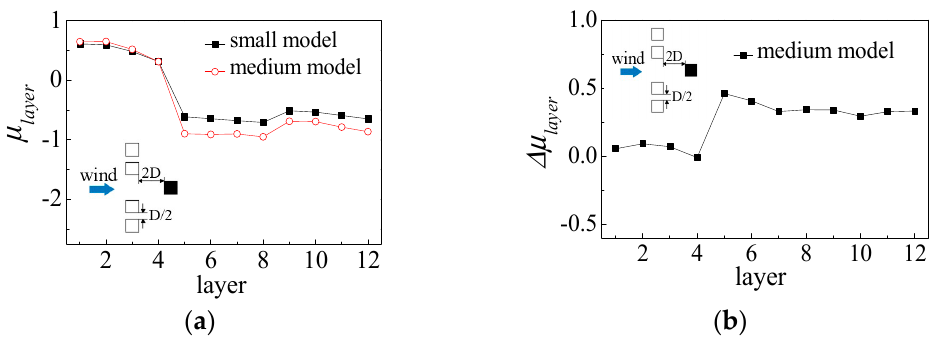
Figure 16. Wind tunnel test results of test condition 8. ( a ) Layer pressure coefficient; ( b ) relative error